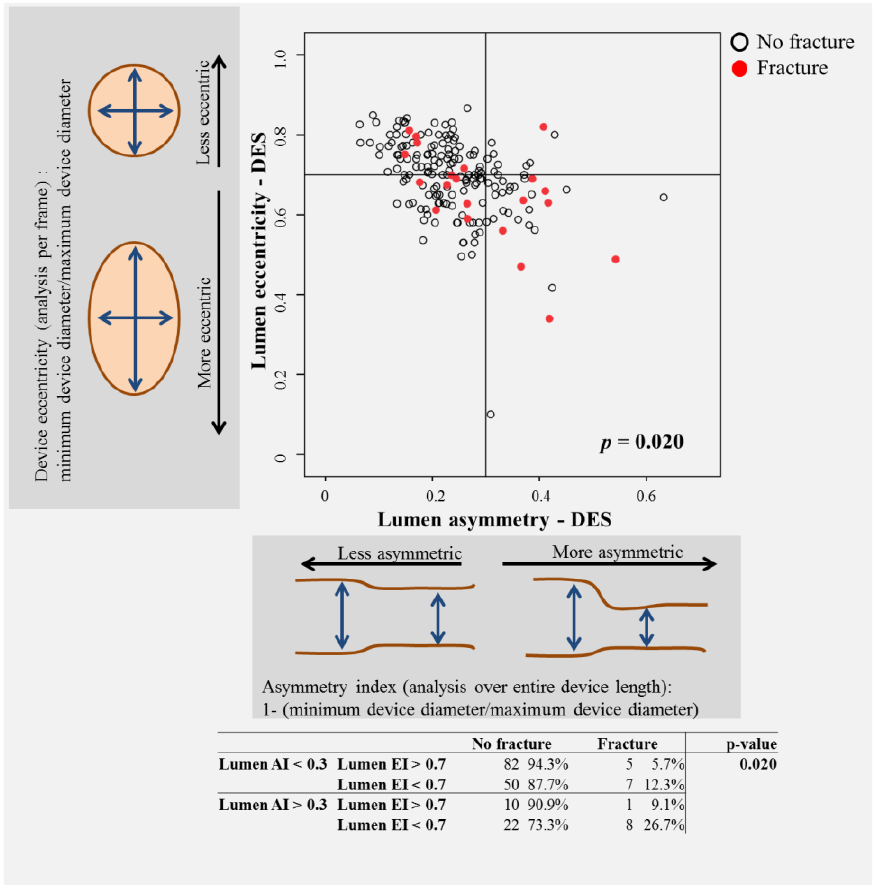
Figure 3. The impact of asymmetry and eccentricity on the prevalence of SF in DES. Both parameters had an impact, and the combination of both had an additive impact.